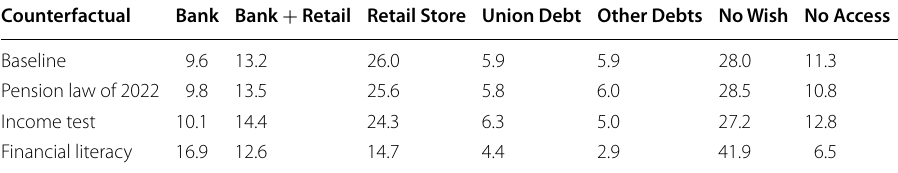
Table 8 Probabilities (in %) for each type of debt choice under different counterfactual policies